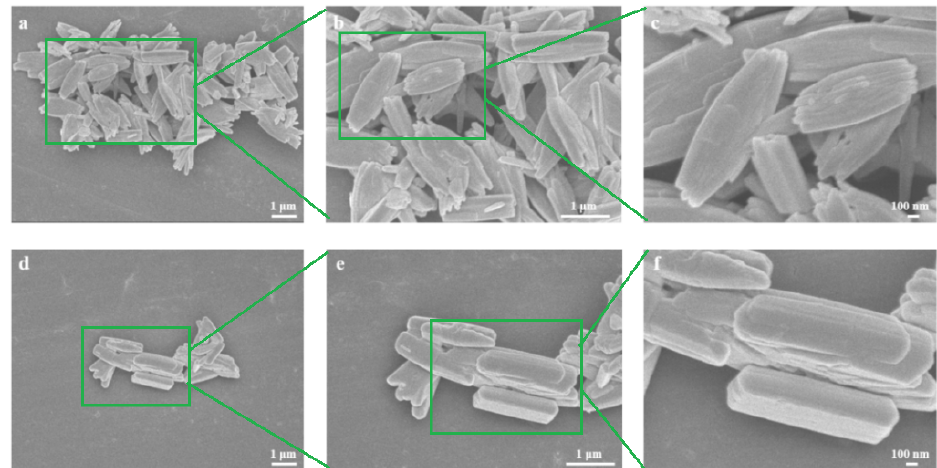
Figure 2. SEM images of untreated Ag 2 NCN nanorods ( a – c ) and treated Ag 2 NCN nanorods ( d – f ) at different magnifications.